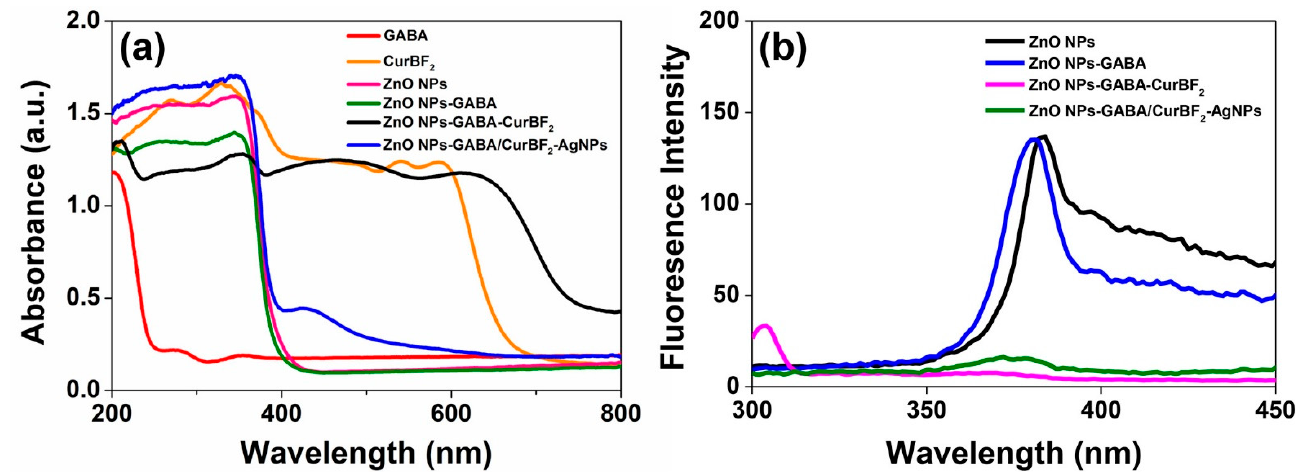
Figure 6. ( a ) UV–VIS diffuse reflectance spectra of free GABA and CurBF 2 , and powders of ZnO NPs, ZnO NPs-GABA, ZnO NPs-GABA-CurBF 2 , and ZnO NPs-GABA/CurBF 2 -AgNPs at room temperature. ( b ) Fluorescence spectra of ZnO NPs, ZnO NPs-GABA, ZnO NPs-GABA-CurBF 2 , and ZnO NPs-GABA/CurBF 2 -AgNPs with slit widths at 5 nm/5 nm excited at 260 nm.